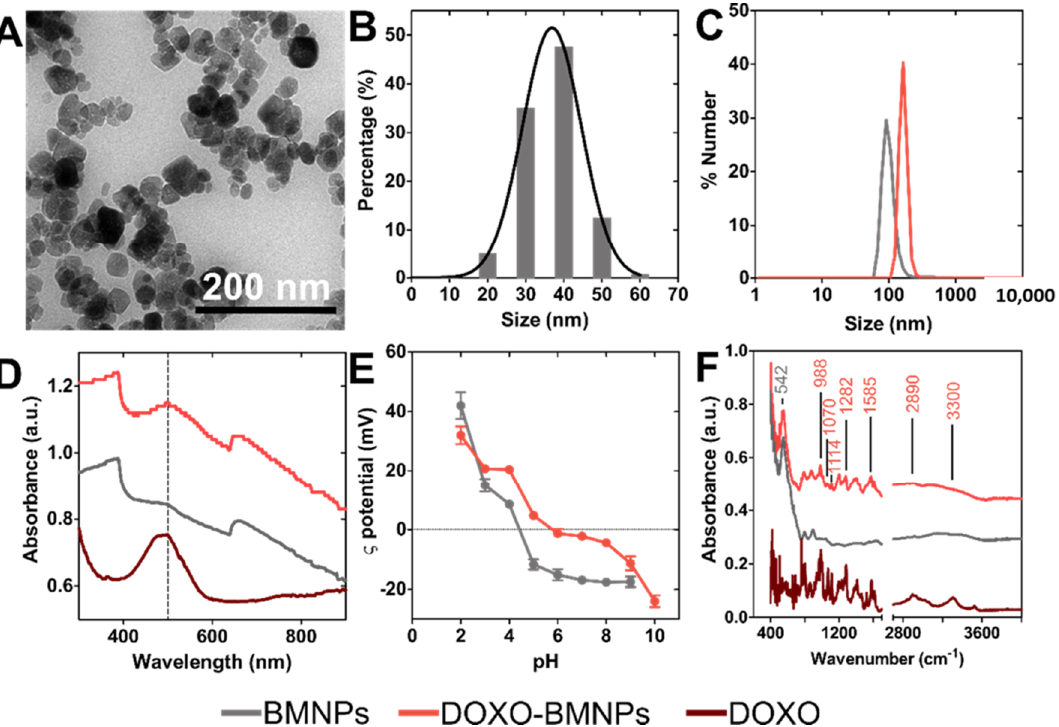
Figure 1. Nanoparticle and nanoassembly characterization. ( A ) Transmission electron microscopy (TEM) images of biomimetic magnetic nanoparticles (BMNPs). ( B ) BMNPs’ size distribution measured by TEM. ( C ) BMNPs’ and DOXO- BMNPs’ size distribution measured with DLS (number distribution). ( D ) UV − vis − NIR absorbance spectra, ( E ) ζ -potential and ( F ) ATR-FTIR spectra of DOXO, BMNP and DOXO-BMNP nanoassemblies. In panels ( C – F ), the gray (black) color corresponds to BMNPs (DOXO-BMNP